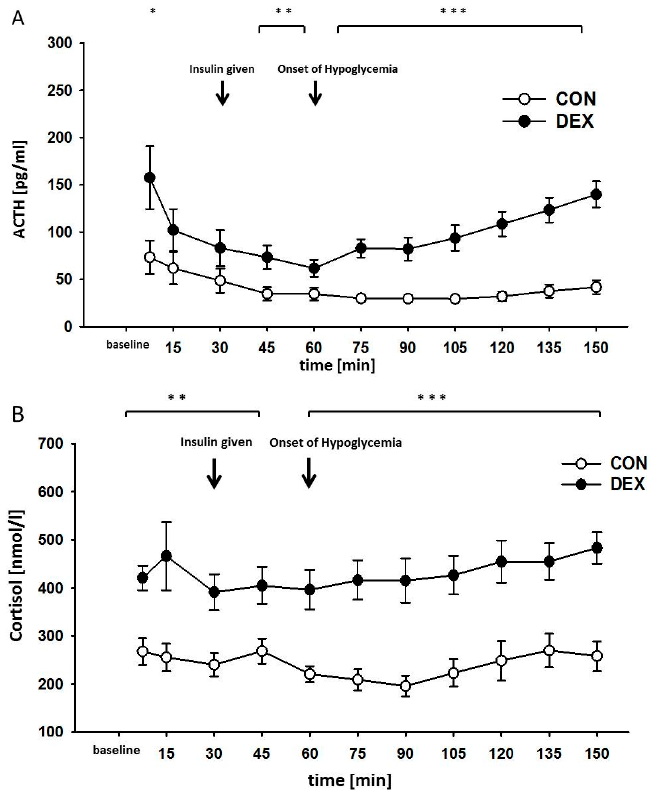
Figure 3. ACTH ( A ) and cortisol ( B ) plasma concentrations during hypoglycemic clamp. Data are given as means ± SEM for the control group (CON) and the dexamethasone-treated group (DEX), * p <0.05, ** p <0.03, *** p